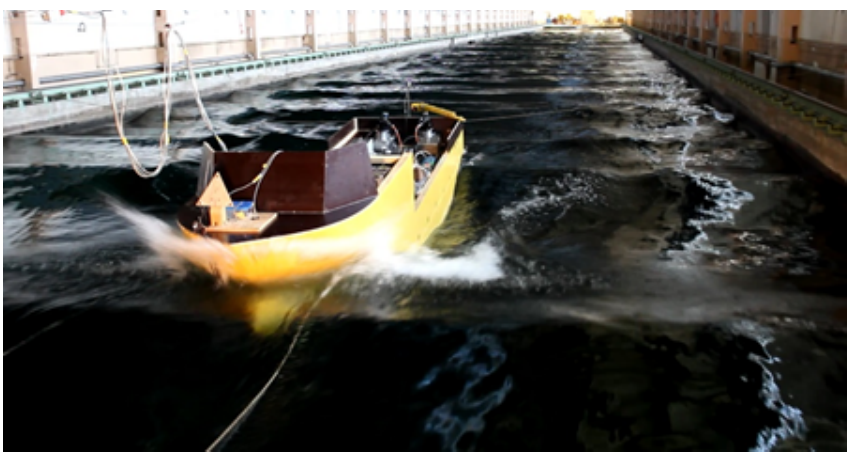
Figure 1. The model tests performed on a free-running reduced-scale model of ship in the deepwater towing tank, located in the Maritime Advanced Research Centre (CTO S.A.) [7].